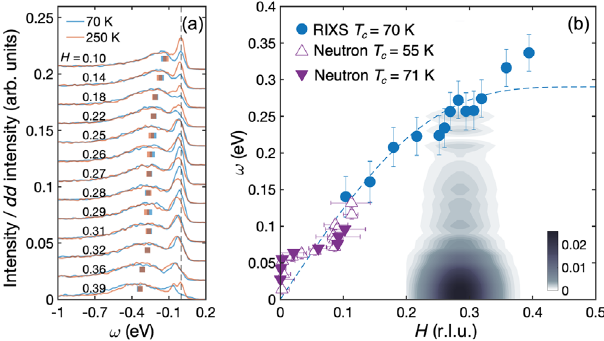
FIG. 4. (a). RIXS spectra for Hg1201 at numerous wave vectors along [1, 0], obtained with π polarization. Data are vertically shifted for clarity. Blue and red bars indicate the paramagnon energy obtained from fits to a damped harmonic oscillator (see text and Ref. [68]). (b) Dispersion of magnetic excitations in ¼ 70 K) Hg1201 measured by RIXS (this work; p ¼ 0 . 086 , T c and neutron scattering for two Hg1201 samples: one with nearly ¼ 71 K [53], and the other with a the same doping level and T c ¼ 55 K [66]. slightly lower doping level of p ≈ 0 . 064 and T c Blue dashed line, heuristic fit to nearest-neighbor spin-wave theory (see text). Error bars for RIXS data are set to 30 meV, i.e., half of the FWHM energy resolution. The contour indicates the relative charge intensity at 70 K [Fig.